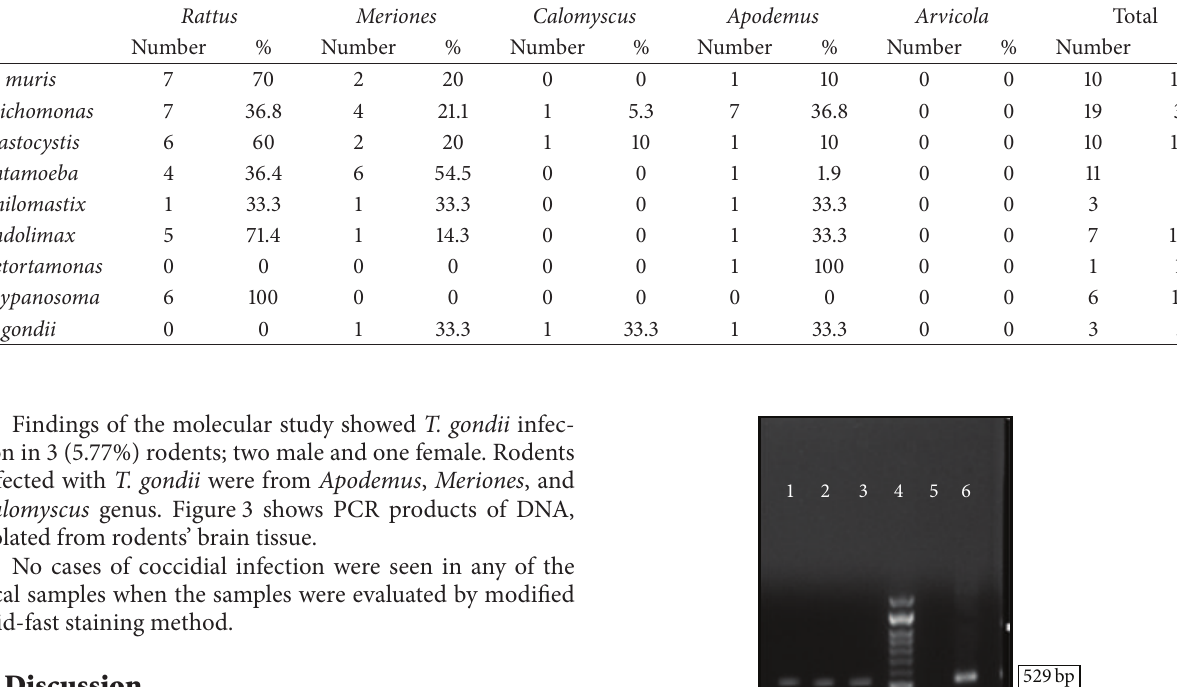
Table 1: Distribution of protozoan infection according to genus of the studied rodents.